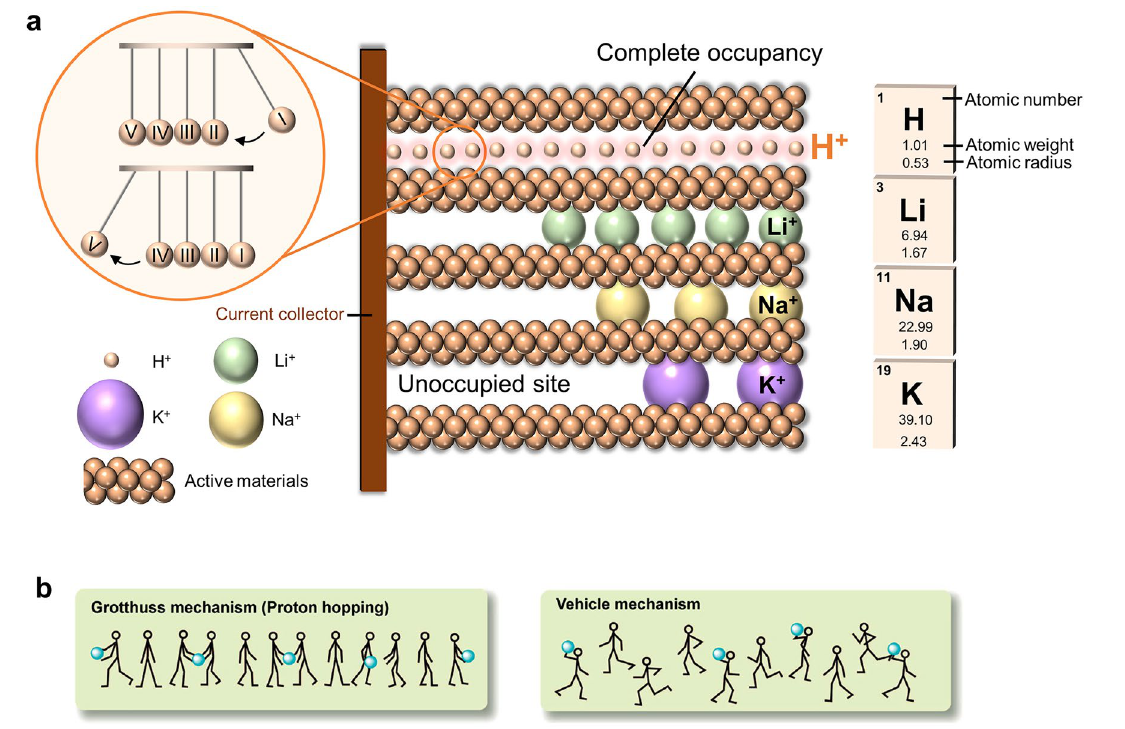
Fig. 1 a Schematic of the diffusion of different charge carriers in electrodes. Protons with the smallest atomic radius and weight, as well as Grotthuss conduction have great potential to quickly transport in electrodes [21]. Copyright 2020, Wiley–VCH. b Illustration of proton conduc- tion in Grotthuss mechanism and vehicle mechanism. The men represent water or base, while the balls represent protons [14]. Copyright 2013, Springer